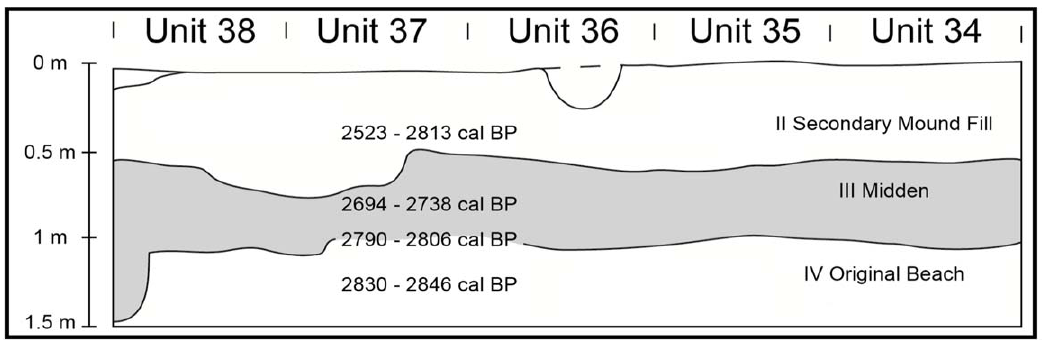
Figure 2. West stratigraphic profile of mound excavation with U/Th dates. Unit provenience is given in excavation plan Figure S1. Chronological intervals for Strata II to IV are based on minimum/maximum dates for U/Th date ranges within stratum as given in Table 1. There is no Stratum I in this part of the site.